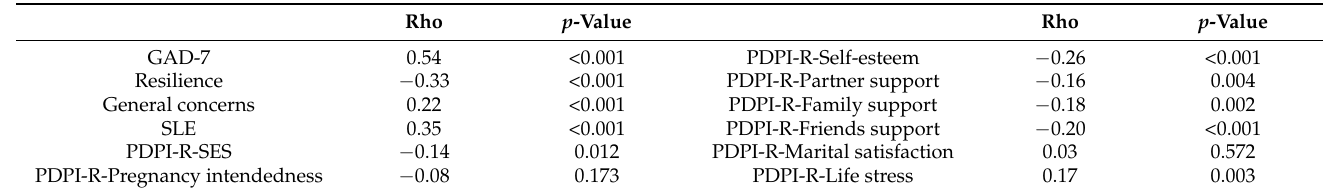
Table 3. Correlations of the psychological variables with depression